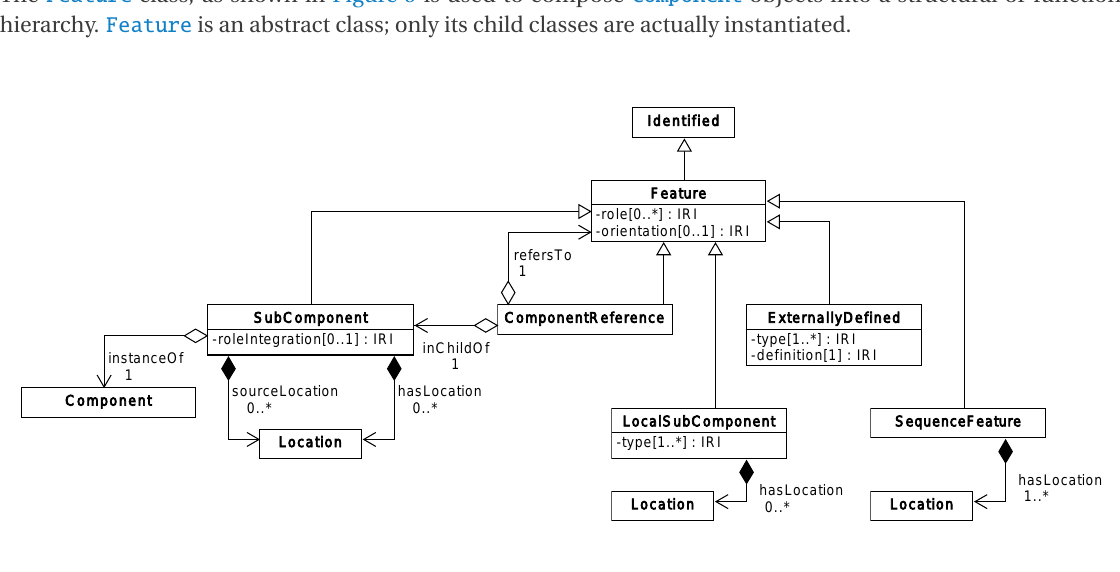
Figure 9: Diagram of the Feature class, its children, and associated